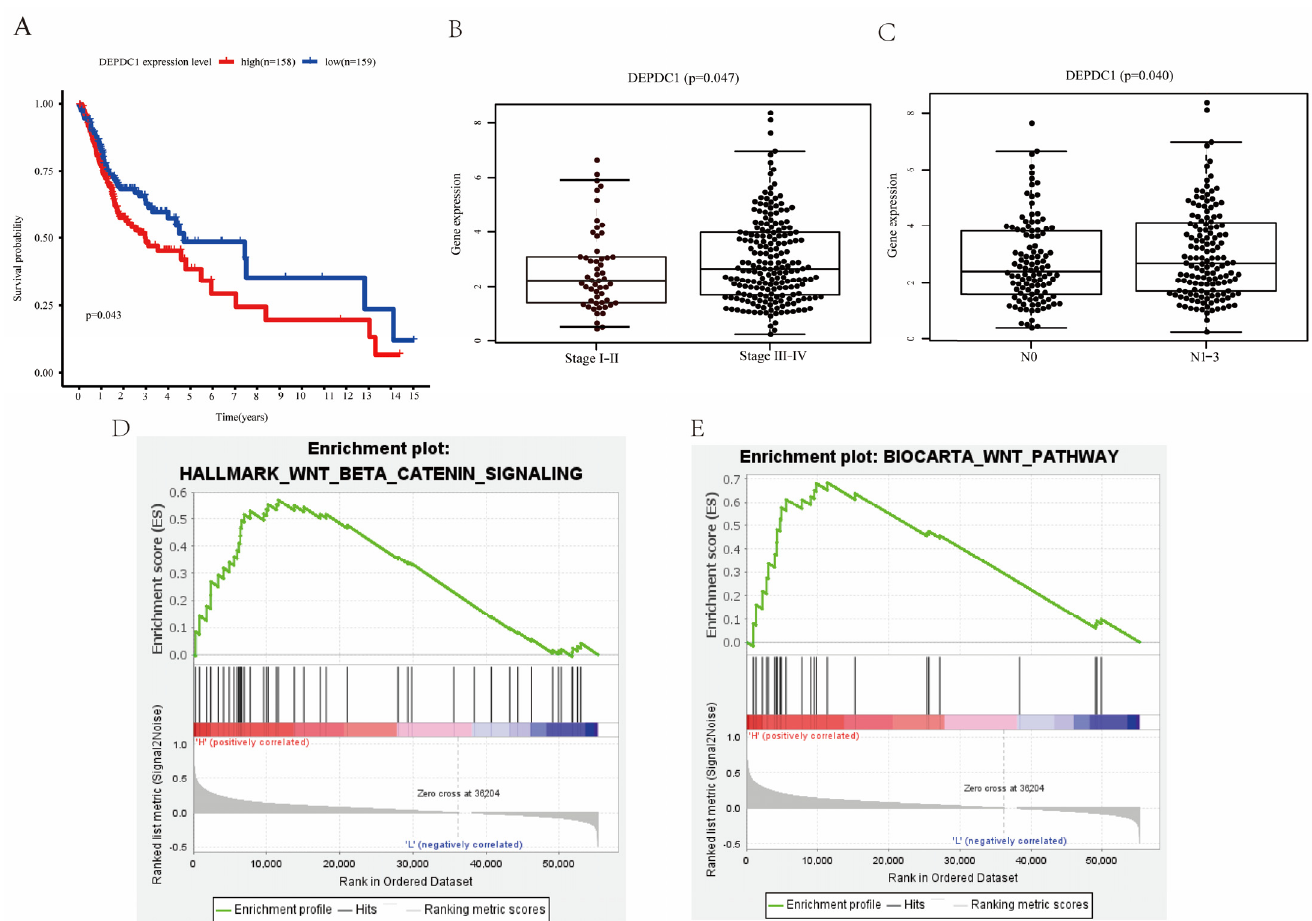
Figure 3. DEPDC1 was identified as a potential biomarker. ( A ), Survival analysis showed that high DEPDC1 expression levels meant poor overall survival. ( B , C ), DEPDC1 expression level was related to advanced stage and lymph node metastasis in OSCC. ( D , E ), GSEA suggested that high DEPDC1